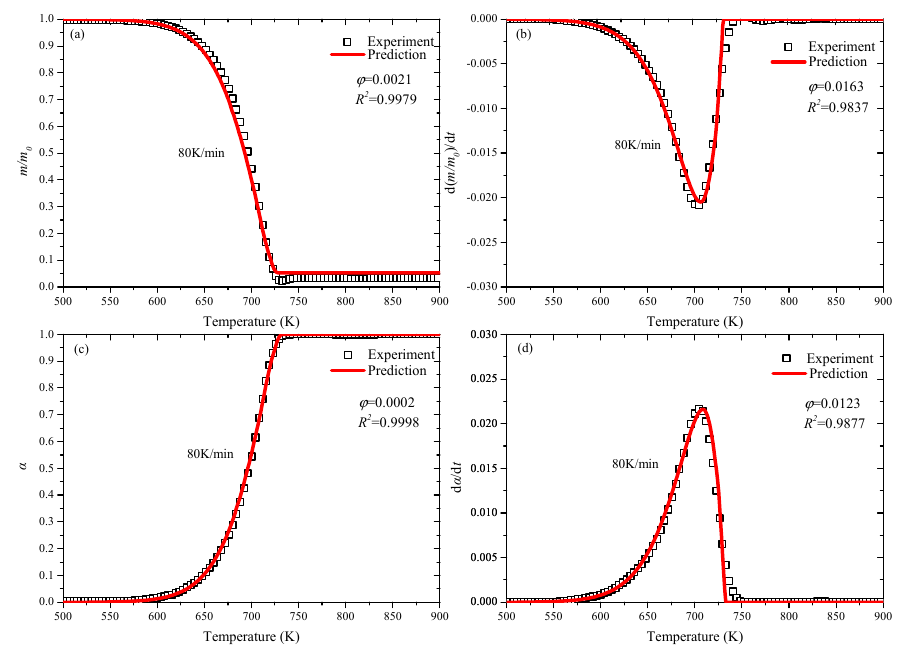
Figure 4. Predicted and experimental curves in air at 80K/min: ( a ) m/m 0 ; ( b ) d(m/m 0 )/dt ; ( c ) α ; ( d ) d α /dt .